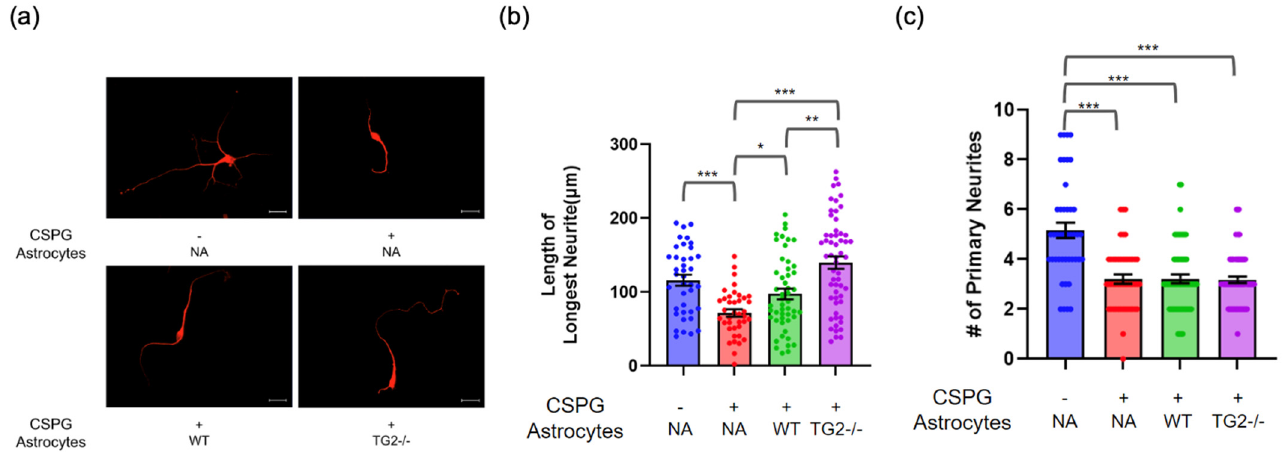
Figure 1. TG2 − / − astrocytes promote neurite outgrowth to a greater extent than wild-type (WT) as- trocytes on an inhibitory matrix (CSPG). ( a ) Representative MAP2 images of neurons grown on poly-D-lysine (PDL) only ( − ) or PDL+CSPG (+) matrix and paired with WT, TG2 − / − , or no astrocytes (NA) (scale bar = 20 µm) ( b ) Quantitation of neurite length on CSPG (n = 39–57 neurons per condition from three independent biological replicates, two-way ANOVA * p < 0.05, ** p < 0.01, *** p < 0.001). ( c ) Quantitation of primary neurite number on CSPG (n = 43–68 neurons per condition from three independent biological replicates, two-way ANOVA *** p < 0.001).